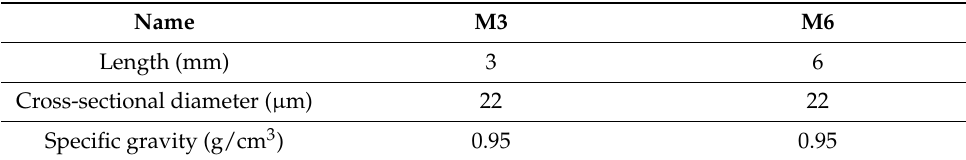
Table 3. Proportions of the mixtures.